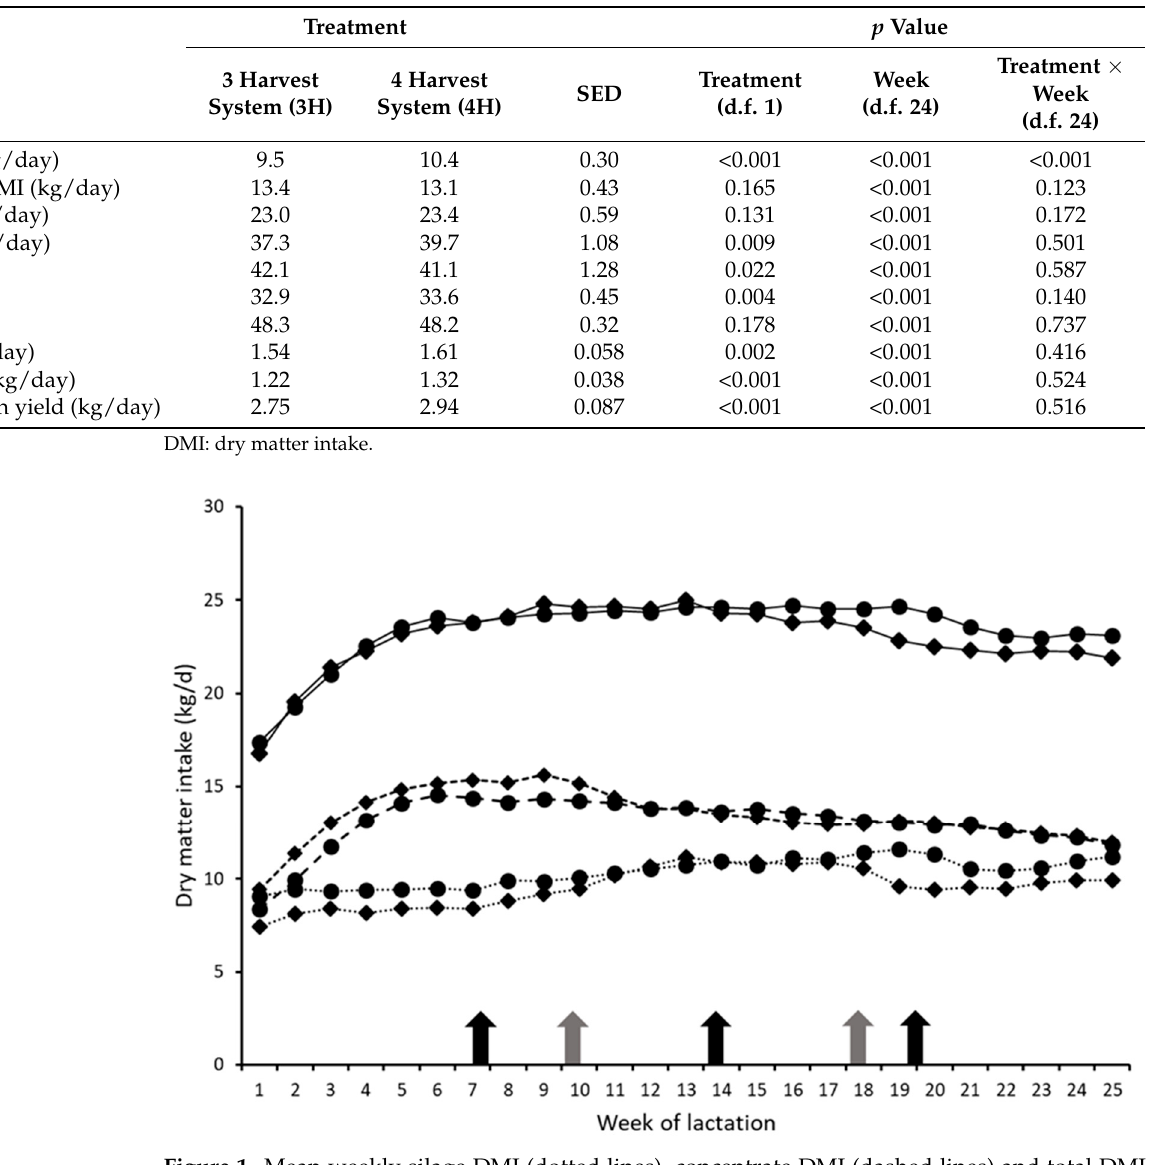
Table 3). Milk yield, milk fat content, milk protien content and milk fat plus protein yield varied ( p > 0.001) over the experimental period (Figure 2a–d, respectively). There were no interactions between treatment and week of lactation for any milk production parameter ( p < 0.05).